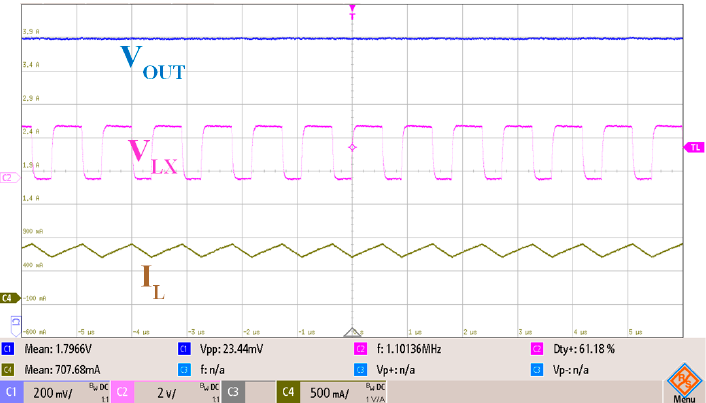
Figure 11. Measured heavy load steady-state response of the proposed DC-DC buck converter ( V OUT = 1.8 V; I LOAD = 700 mA) .